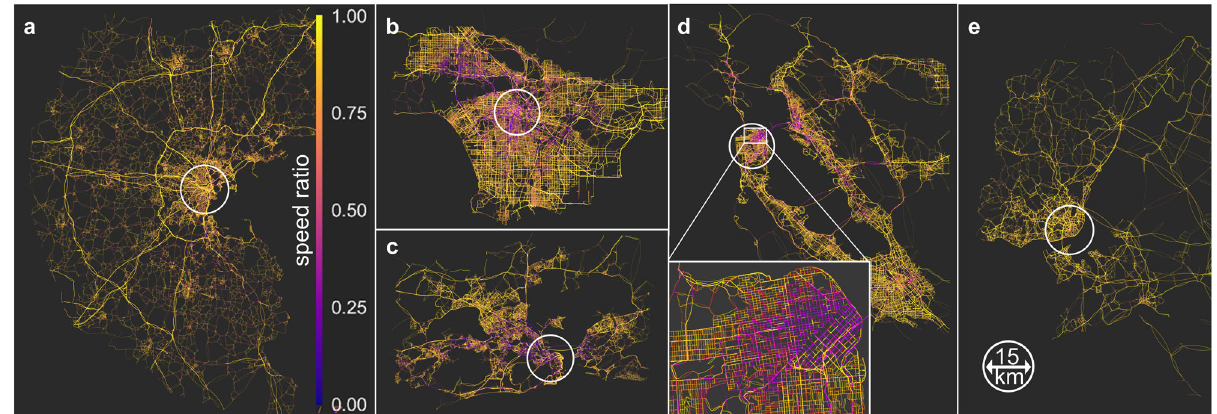
Fig. 2 Maps of the traf fi c networks for each city. The networks depicted represent the morning traf fi c conditions (at 09:00) on a weekday in a Boston, b Los Angeles, c Rio de Janeiro, d San Francisco Bay Area, and e Lisbon. The speed ratios are obtained by dividing traf fi c speed by the speed limit.